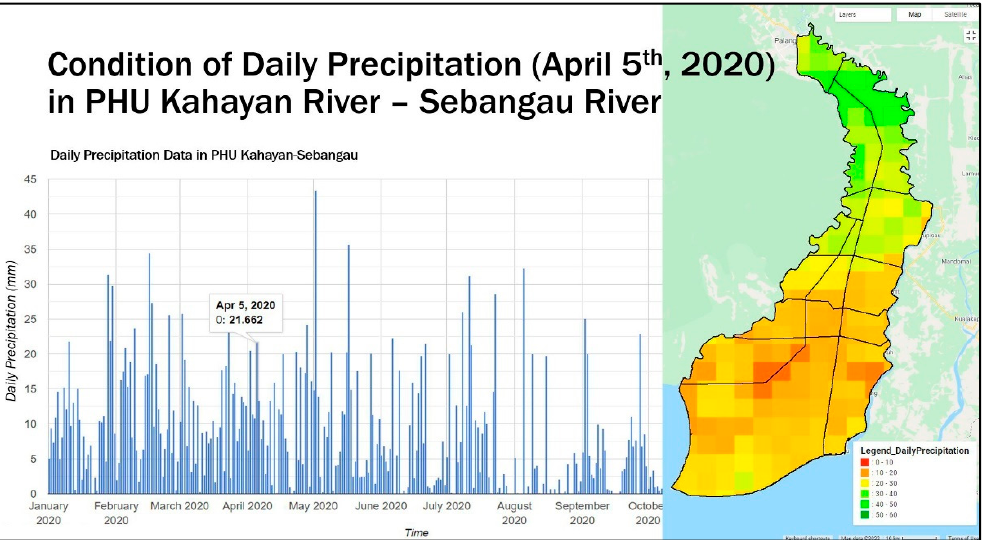
Figure 7. An example of CHIRPS rainfall data in 2020 in chart form ( left ) and the spatial rainfall distribution that occurred at Kahayan–Sebangau PHU ( right ) on 5 April 2020. (data source: CHIRPS using Google Earth Engine; processed by the authors).